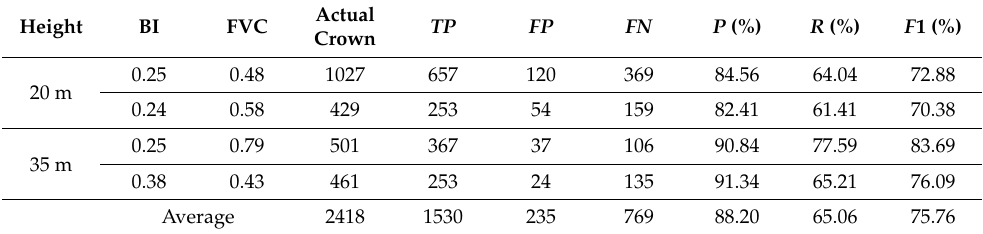
Table 6. Statistical table of crown recognition (color vector +